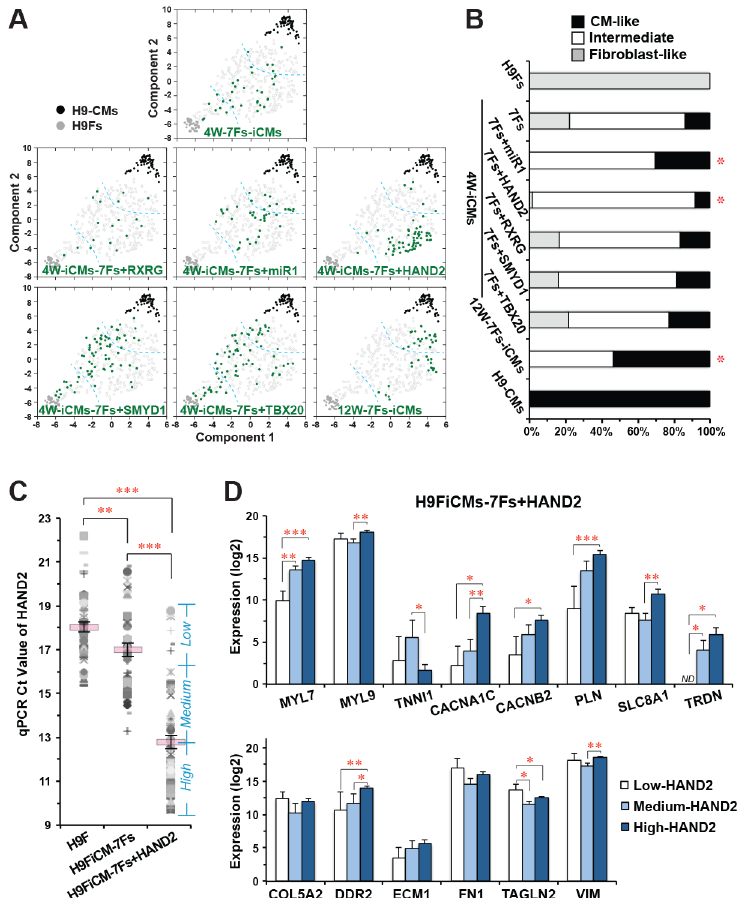
degreein individual iCMs reprogrammedby 7Fs plus one extra factor, includingmicroRNA-1 (n = 39), HAND2 (n = 61), RXRG (n = 18), SMYD1 (n = 74), and TBX20 (n = 74). Two dash lines were insertedto assort iCMs